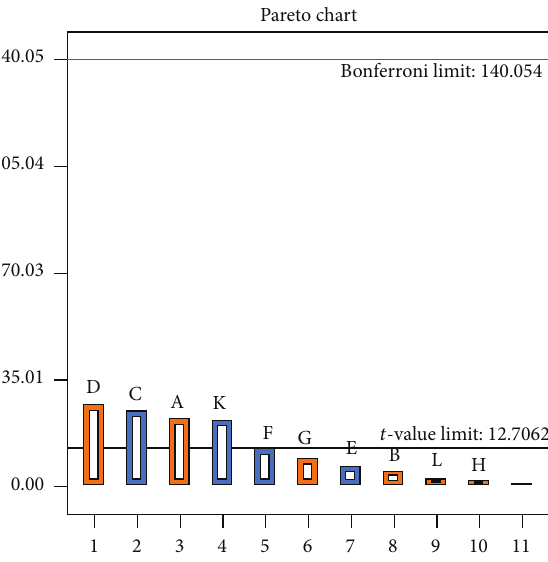
Figure 6: 𝑋1 : Rank of process variables; 𝑋2 : 𝑡 -value of effect. Pareto chart of independent variables (glucose (A; 𝑋1 ), maltose (B; 𝑋2 ), ribose (C; 𝑋3 ), galactose (D; 𝑋4 ), beef extract (E; 𝑋5 ), peanut meal (F; 𝑋6 ), ammonium chloride (G; 𝑋7 ), ammonium sulphate (H; 𝑋8 ), barbital (I; 𝑋9 ), pH (j; 𝑋10 ), and moisture content (K; 𝑋11 )) for rifamycin B production by Nocardia mediterranei MTCC 14 using sunflower oil cake under solid-state